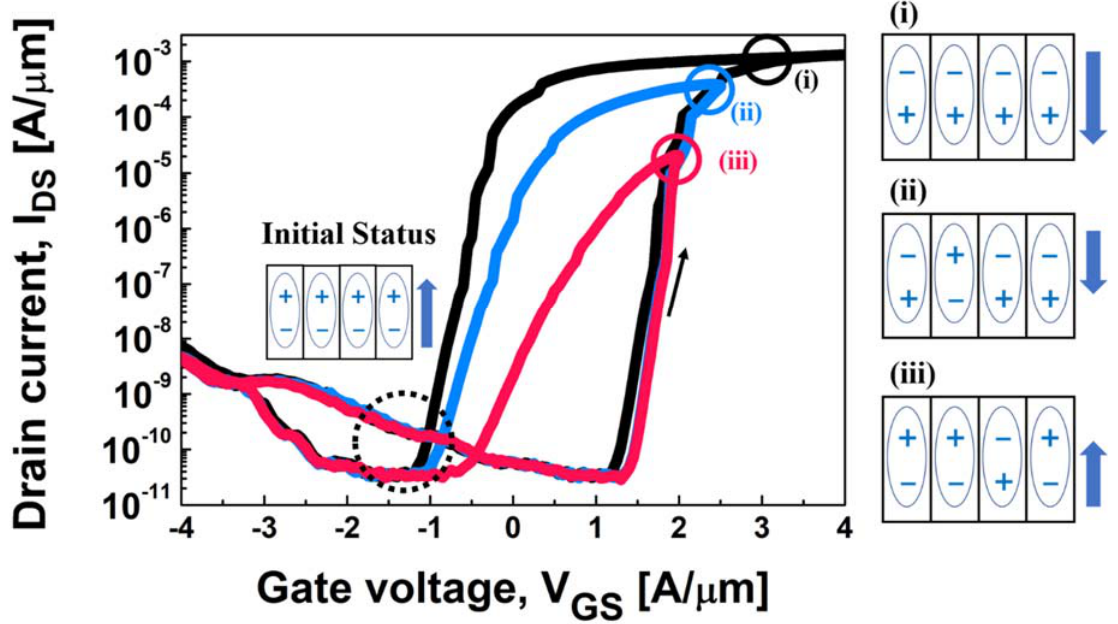
Figure 3. Drain current versus gate voltage with a decreasing upper limit of positive gate voltage. The inset indicates the initial polarization status of a ferroelectric PZT capacitor for a given negative gate voltage (i.e., sufficiently lower than the negative coercive voltage of the PZT capacitor). (i), (ii), and (iii) illustrate the polarization status for a few different upper limits of positive gate voltage.